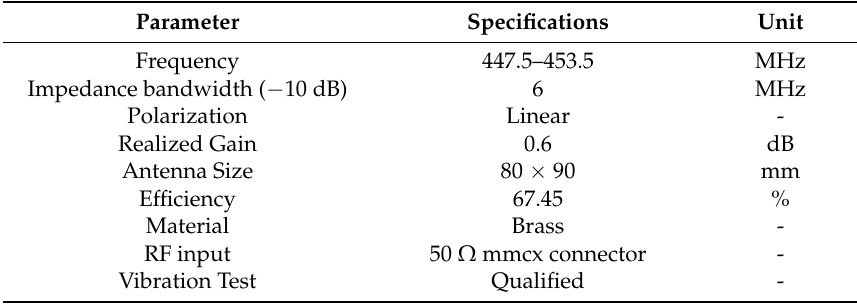
Figure 12. Vibration test setup of the proposed antenna with nanosatellite structure. Aluminum 7075 material based 2U nanosatellite structure was considered for the test as 100+/ − 0.1 mm wide (+X, +Y axes); 227+/ − 0.1 mm tall (+Z axis) and maximum weight was 2.6 kg. Table 2. Summary of the proposed ultra-high frequency (UHF) antenna.